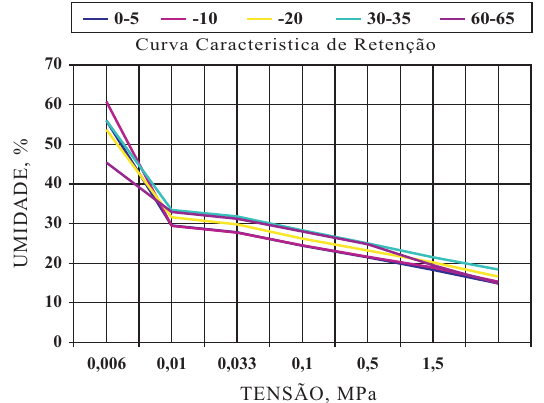
Figura 14. Curvas características de retenção de umidade do solo do tanque B (Laps-Embrapa/ CNPS). Diene